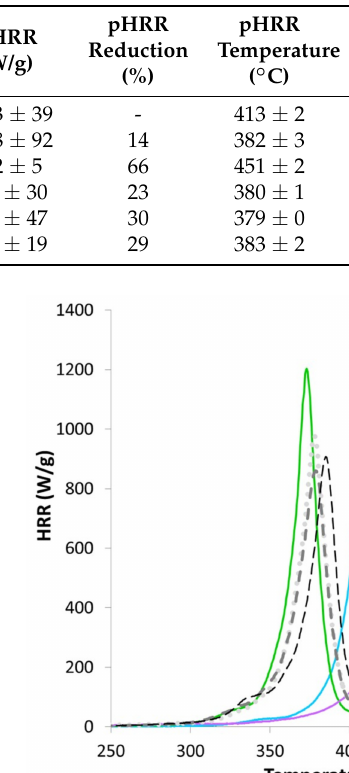
Table 5. Pyrolysis combustion flow calorimetry (PCFC) data for PA and its blends. pHRR: peak of heat release rate; THR: total heat release; ∆ h: heat of complete combustion.